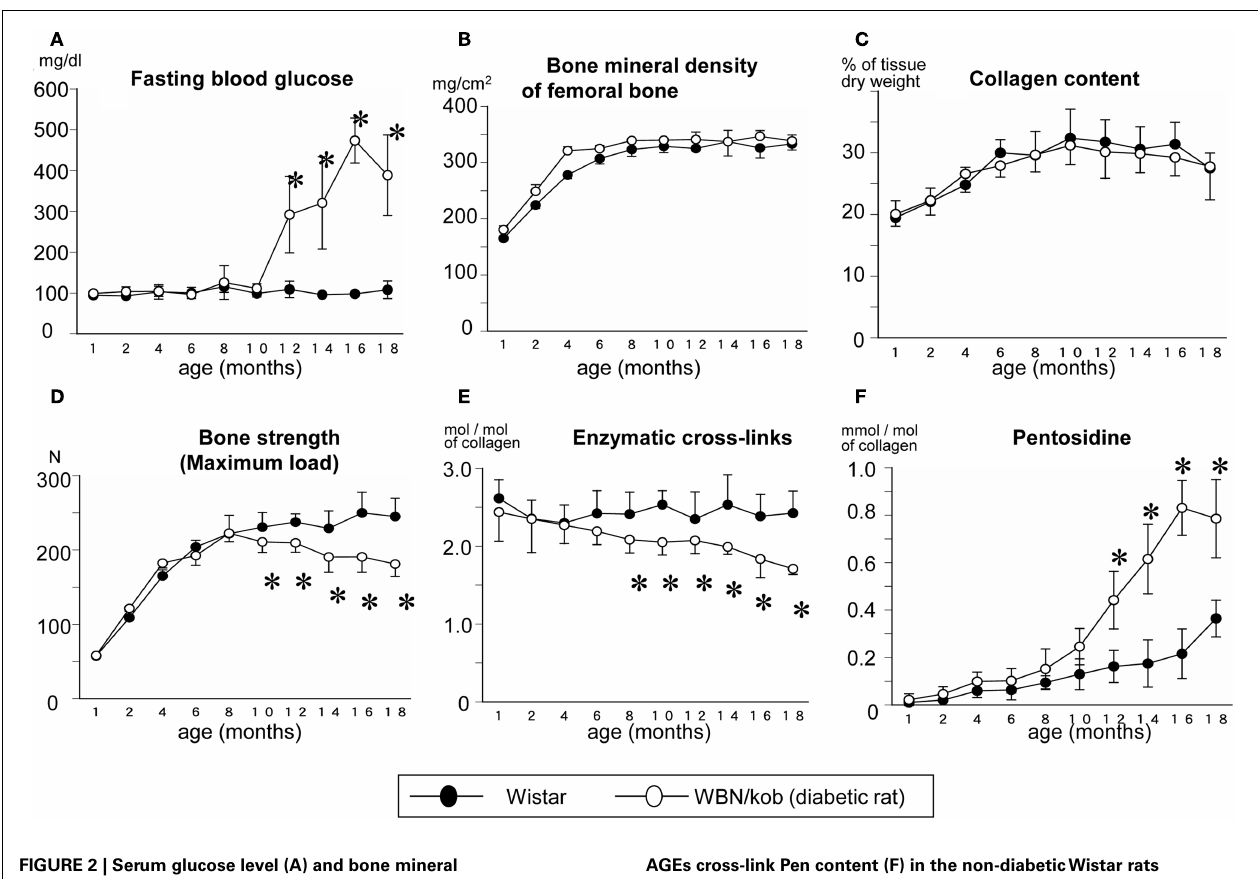
FIGURE 2 | Serum glucose level (A) and bone mineral density (B), collagen content in bone (C), maximum load (D), total enzymatic cross-link content (the sum of immature divalent and mature trivalent pyridinium crosslinks) (E), and